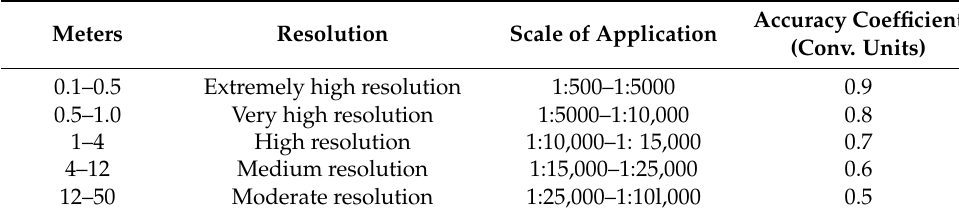
Table 1. Accuracy factor according to material details.